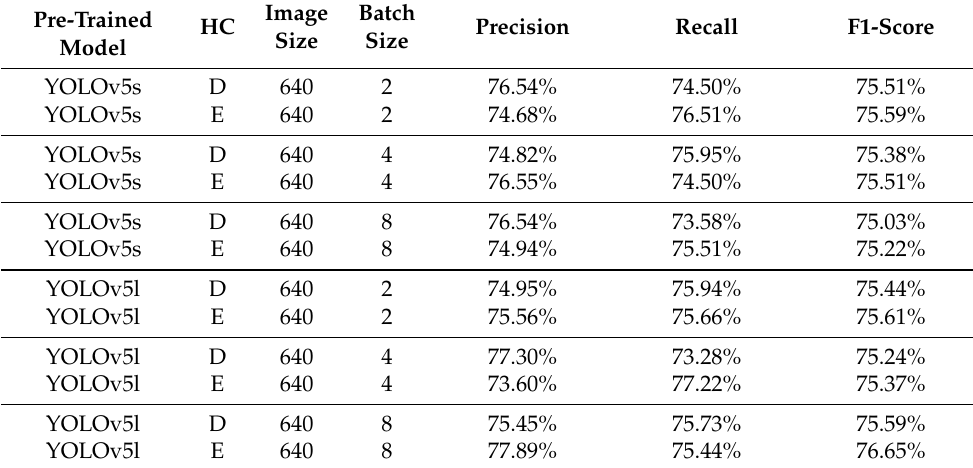
Table 3. Evaluation results for the F1-Score for different hyperparameter configurations (HC), for default values (D) and optimised values with evolution (E).